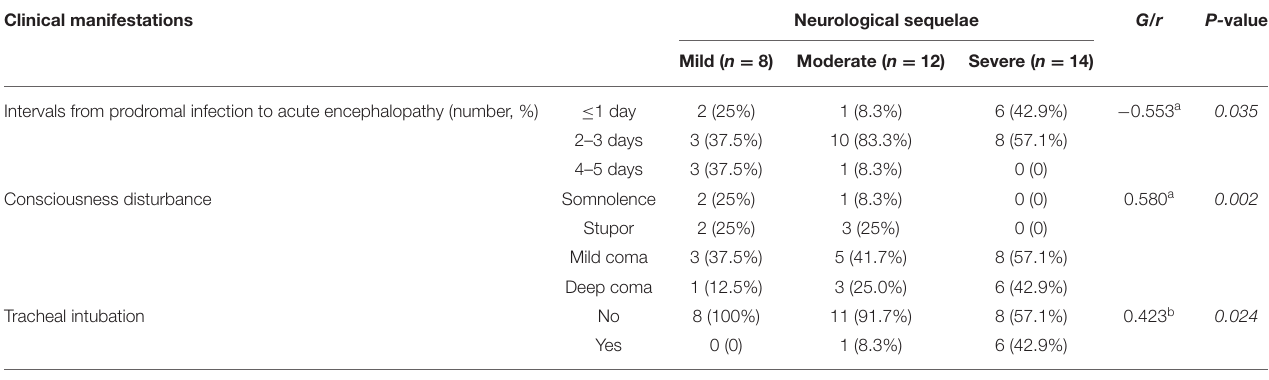
TABLE 2 | The association between clinical manifestations and neurological sequelae of ANE. Clinical manifestations